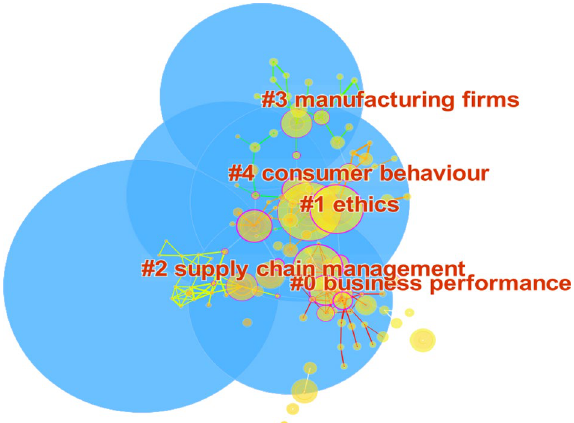
Fig. 3 Clusters in the knowledge domain for the sustainable development of the textile and apparel industry (SDTAI)